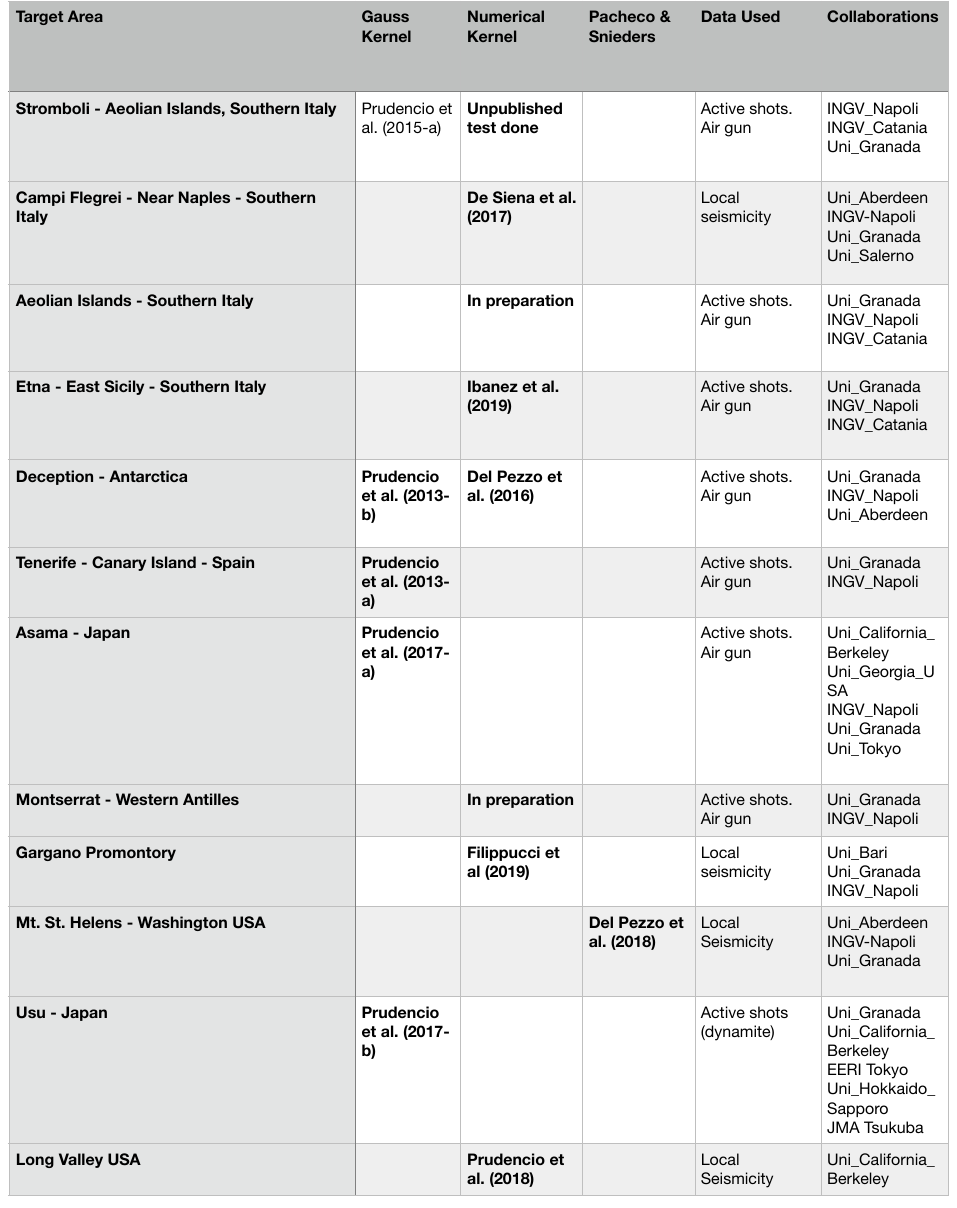
Figure 10. Sensitivity Kernels applied to Volcanoes and Tectonic zones